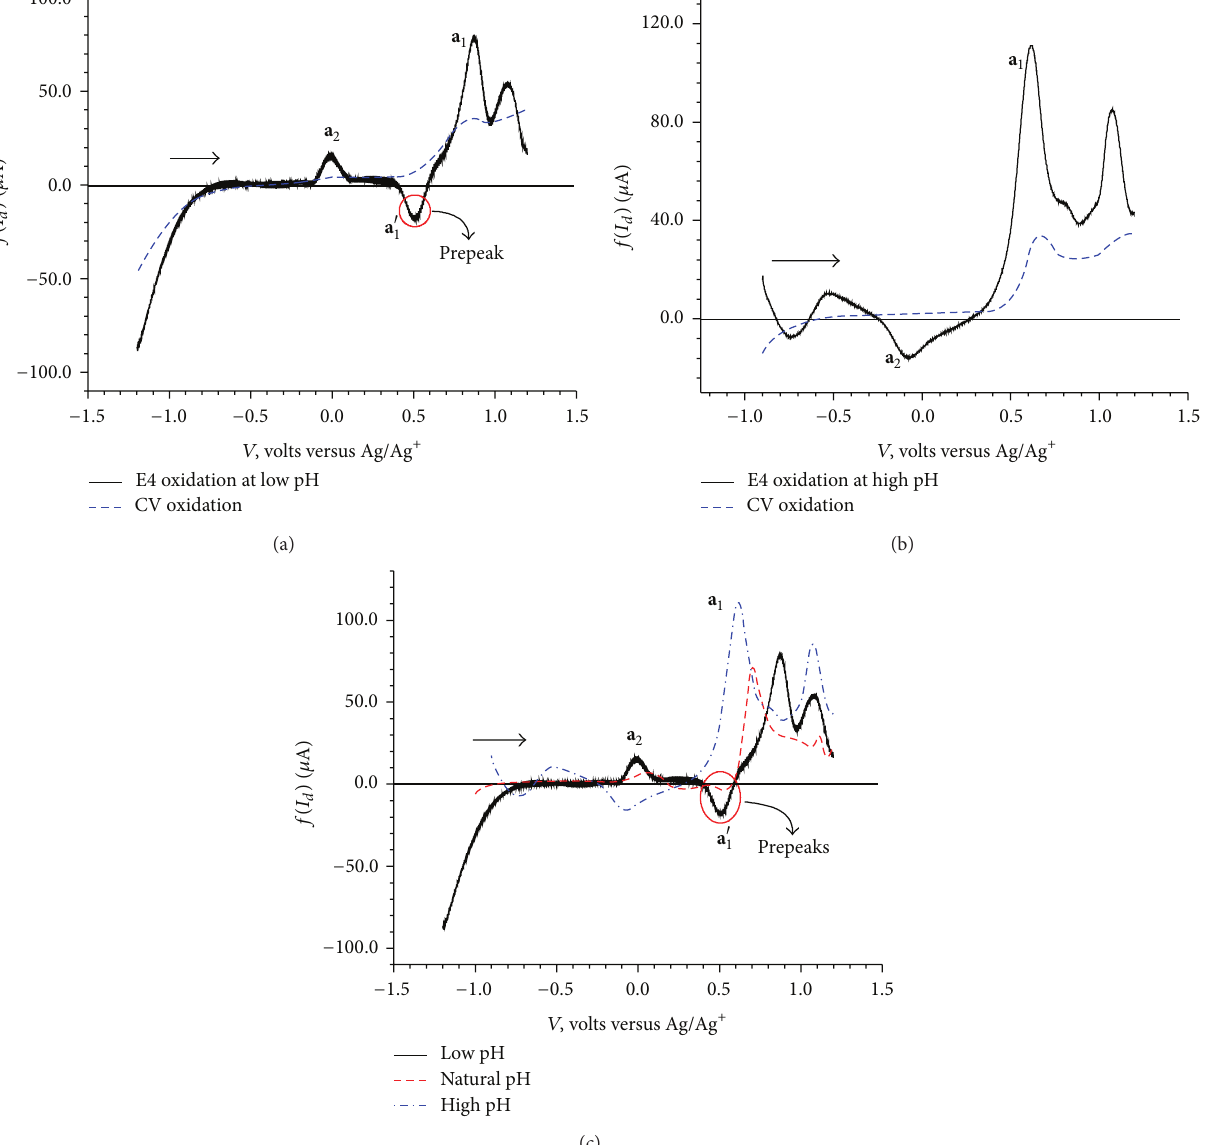
Figure 6: Plots for diffusion current 𝐼 𝑑 for BB: (a) oxidation process at low pH, (b) oxidation process at high pH, and (c) overlay plot for oxidation